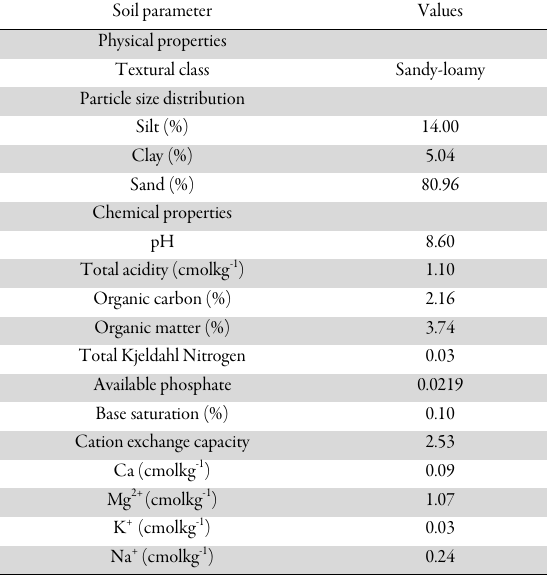
Table 1. Physico-chemical properties of experimental soil Soil